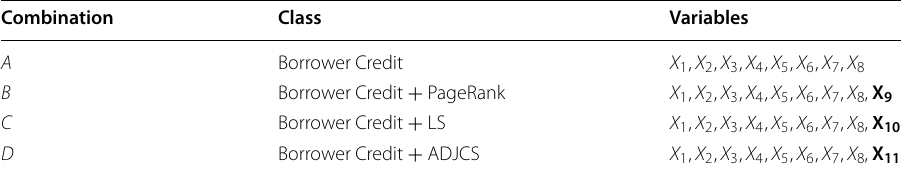
Table 3 Variables combinations (The variables in borrower credit are extracted from borrower information, while PageRank, LS, and ADJCS are extracted from lender information.)